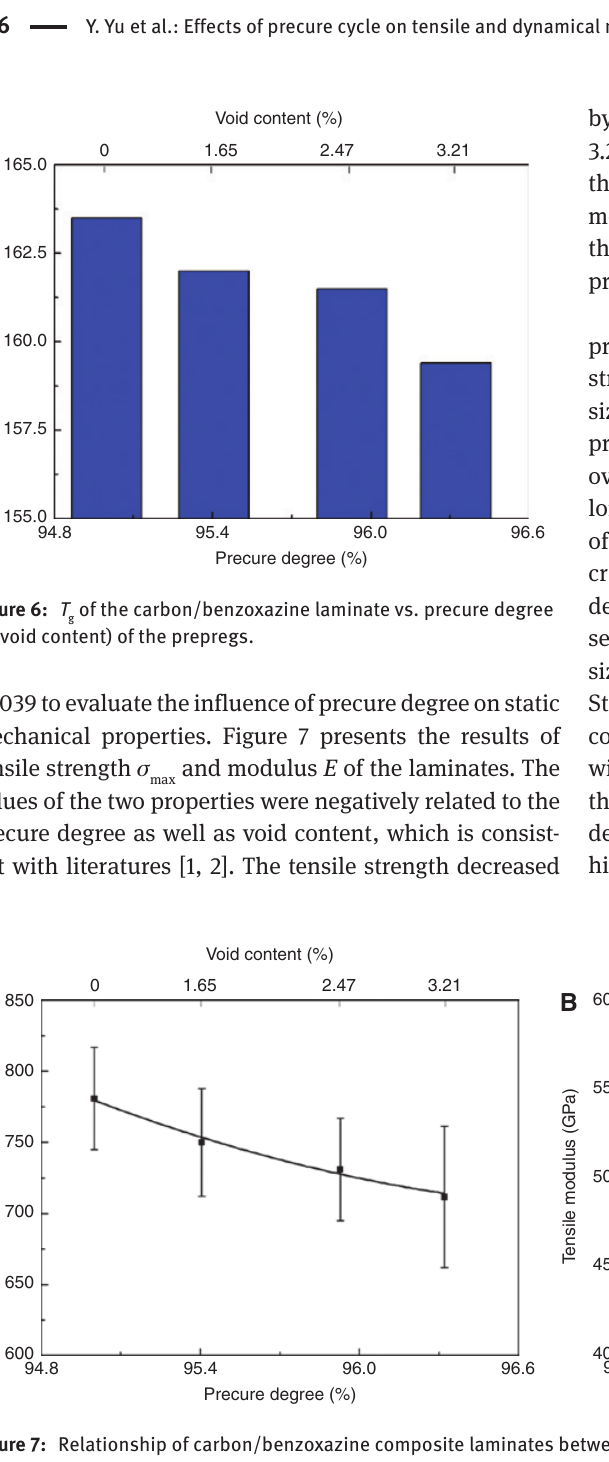
Figure 7: Relationship of carbon/benzoxazine composite laminates between precure degree (or void content) and (A) tensile strength, (B) tensile modulus.